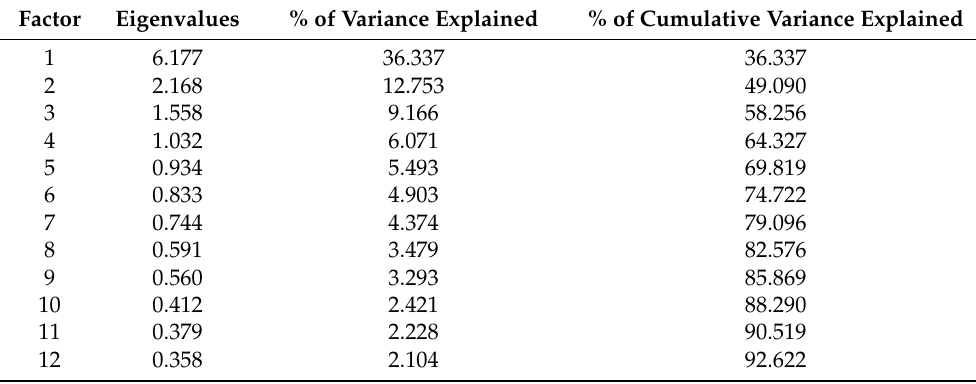
Table 4. Grouping of items by factors according to the percentage of variance